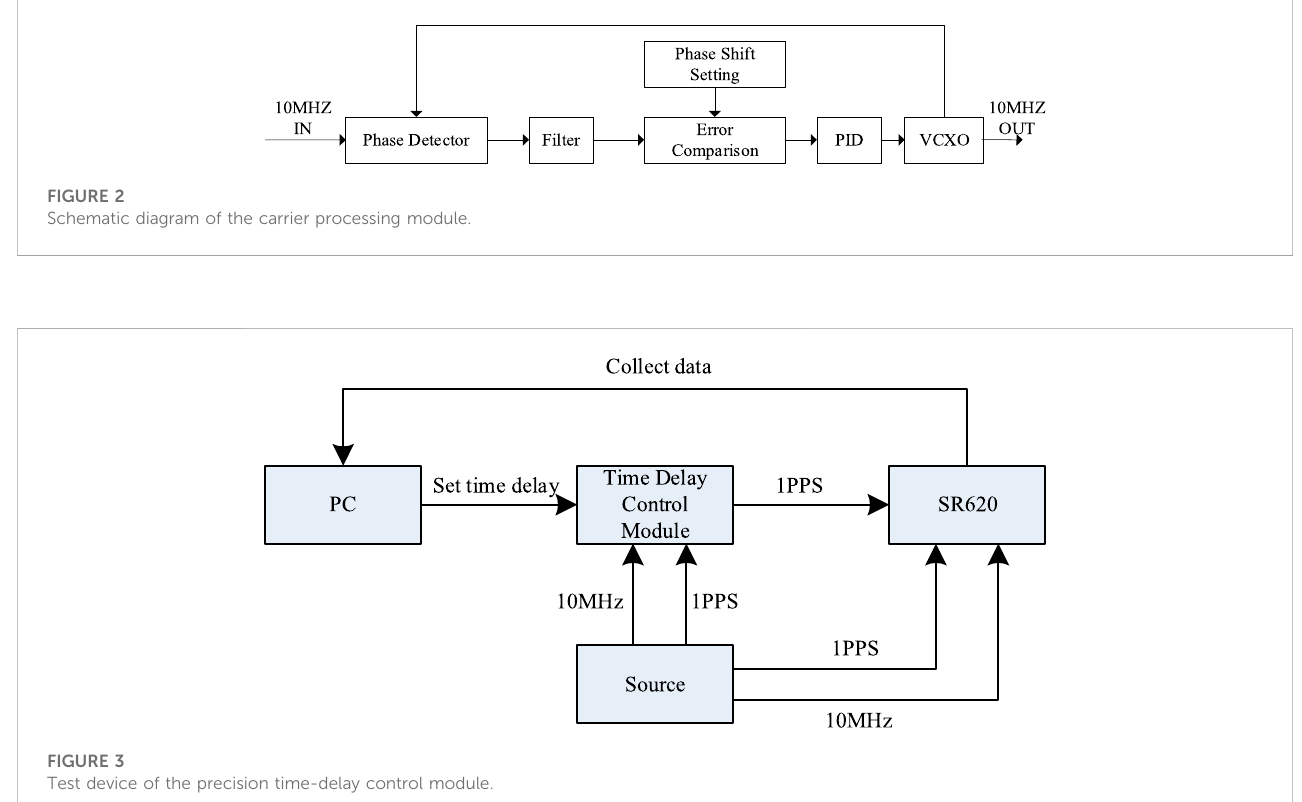
FIGURE 3 Test device of the precision time-delay control